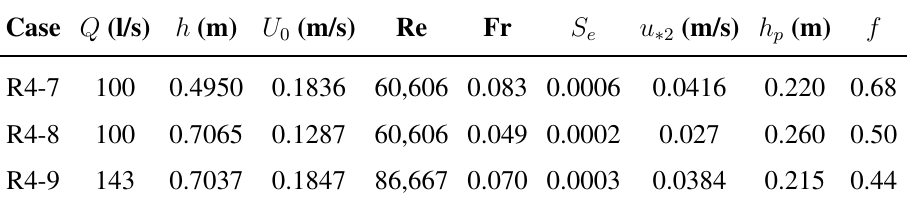
Table 1. Experimental setup (taken from Järvelä